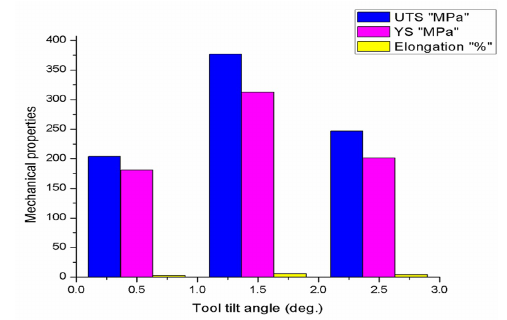
Figure 11: Effect of tool tilt angle on tensile